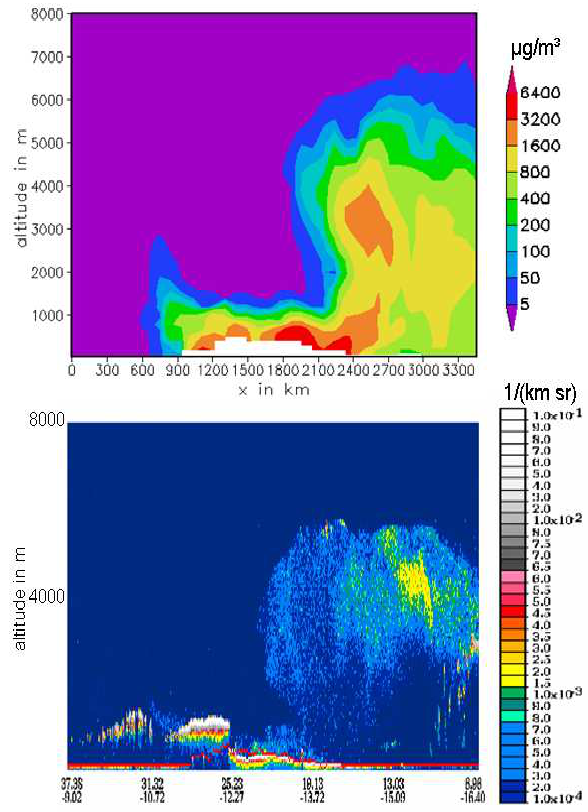
Fig. 8. Top: vertical cross section between 37.5 ◦ N, 9 ◦ W and 7 ◦ N, 16.5 ◦ W for the simulated mass density on 22 June 2007, 03:00UTC. Bottom: CALIPSO lidar-derived attenuated backscat- Figure 8: Top: Vertical cross section between 37.5° N, 9° W and 7°N, 16.5 °W for the ter coefficient at 532nm along the CALIPSO track (between simulated mass density on 22 nd of June 2007, 3 UTC. Bottom: CALIPSO lidar-derived 37.38 ◦ N, 9.02 ◦ W and 6.96 ◦ N, 16.4 ◦ W, indicated by x in Fig. 7, attenuated backscatter coefficient at 532 nm along the CALIPSO track (between 37.38° N, bottom) on 22 June 2007 between 02:40 and 9.02° W and 6.96° N, 16.4° W, indicated by x in Fig. 7, bottom) on 22 June 2007 between 2:40 and 2:54 UTC.